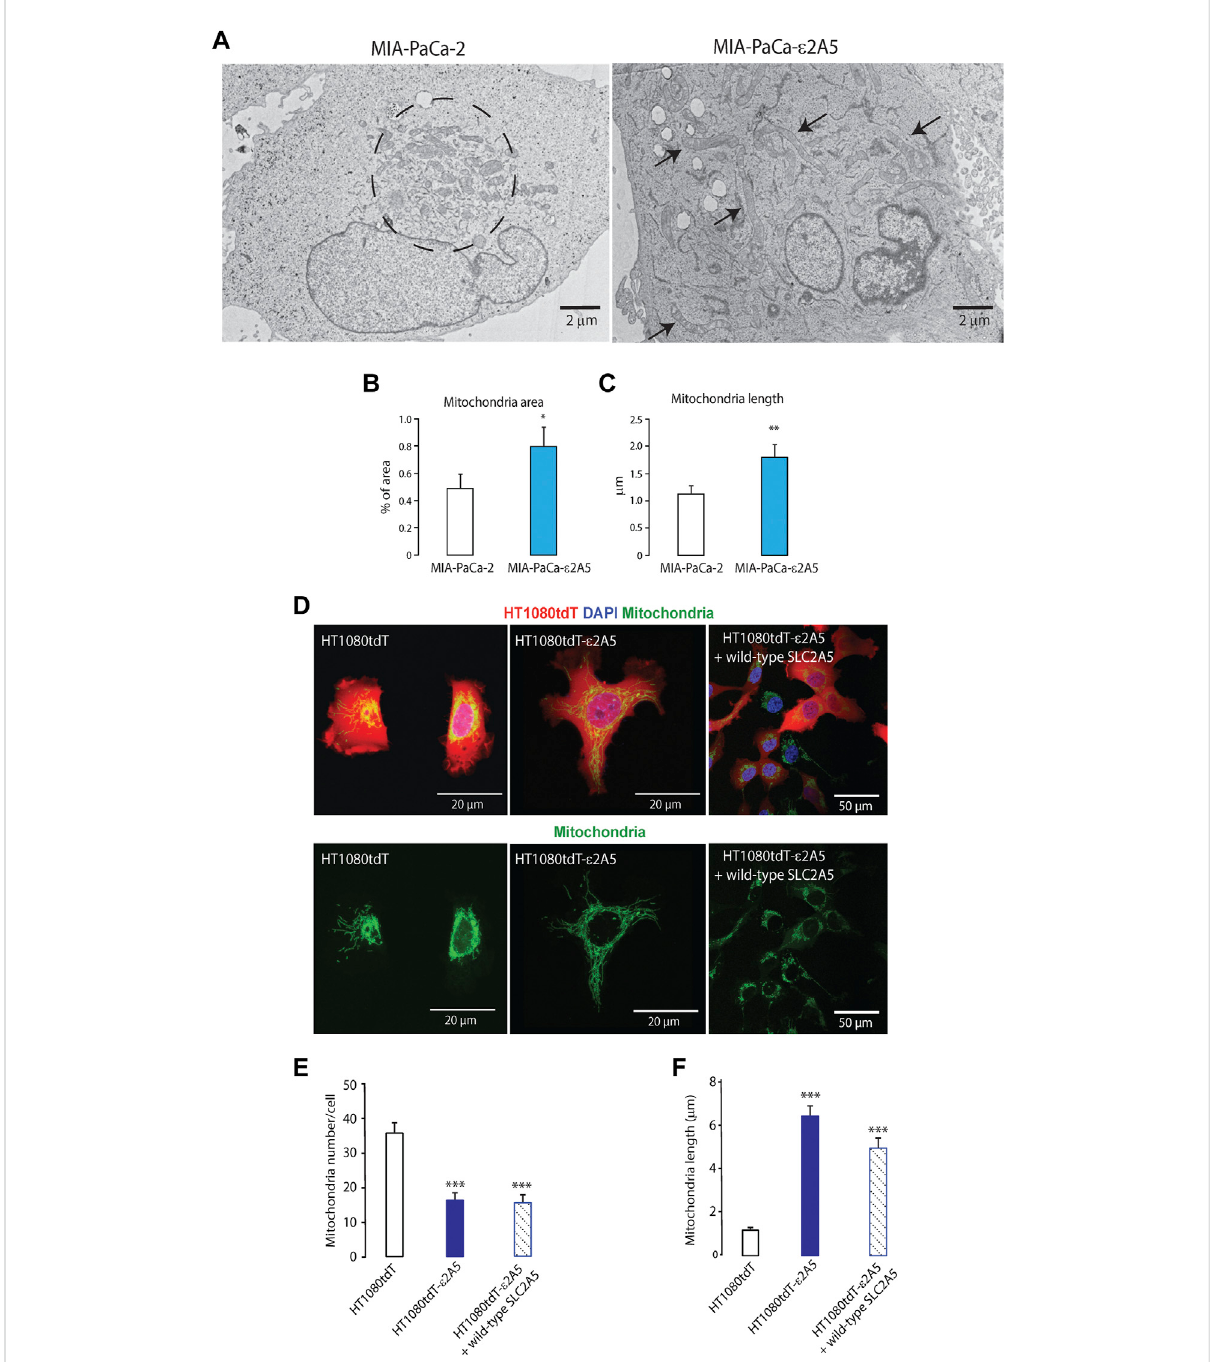
FIGURE 9 Mitochondria localization and dynamics in SLC2A5-de fi cient cancer cells. (A) . Electron microscopy analysis of MIA-PaCa-2 cells shows that mitochondria were localized in the center of these cells in the perinuclear space (encircled). In MIA-PaCa- ε 2A5 cells, mitochondria were spread throughout thecell towards thecell periphery, and appeared elongated(arrows) (n = 3). (B) . and (C) . Mitochondriaarea (B) and length (C) analysesin MIA-PaCa-2 and MIA-PaCa- ε 2A5 cells. * p < 0.0006; ** p < 0.0001 (n = 3). (D) . Confocal images of mitochondria stained with MitoTracker ® Green in red fl uorescent protein-labelled HT1080tdT cells,HT1080tdT- ε 2A5 cells or HT1080tdT- ε 2A5 cells expressing wild-type SLC2A5. Time- lapse video is shown in the Supplementary Video S2 (arrowhead). (E) . Mitochondria number and (F) . mitochondria length in fi brosarcoma HT1080tdT cells, HT1080tdT- ε 2A5 or HT1080tdT- ε 2A5 cells expressing wild-type SLC2A5. *** p < 0.0002 (n =